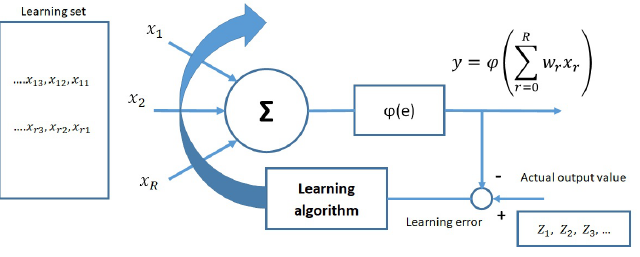
Figure 16. Neuron model